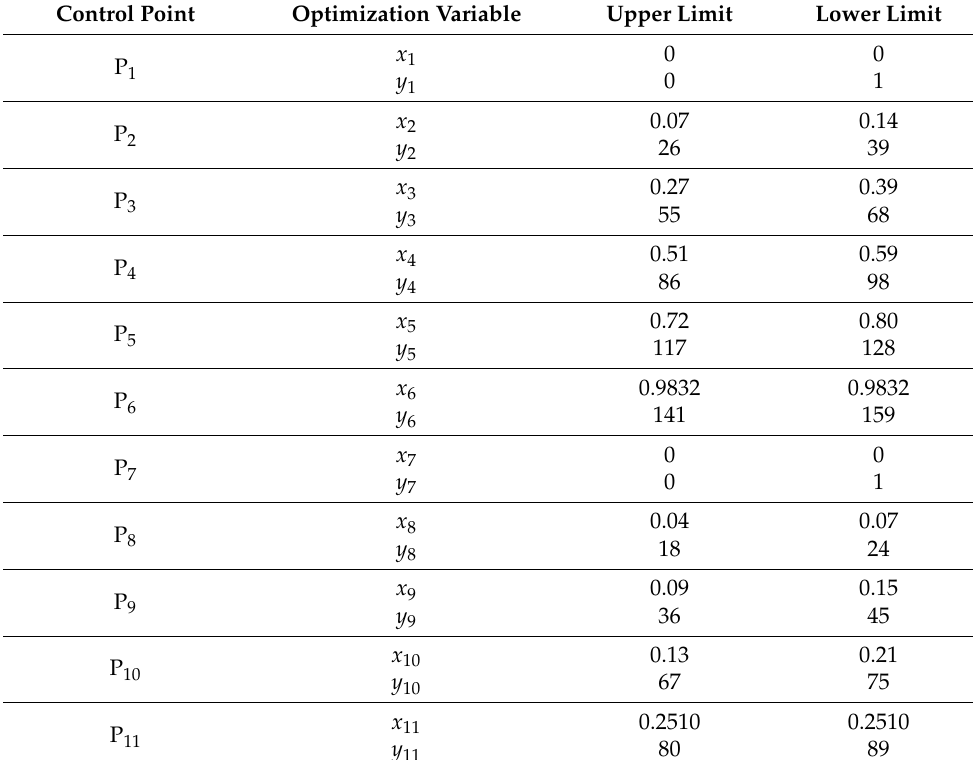
Table 3. Design variables and the variation range of the impeller and guide vane.